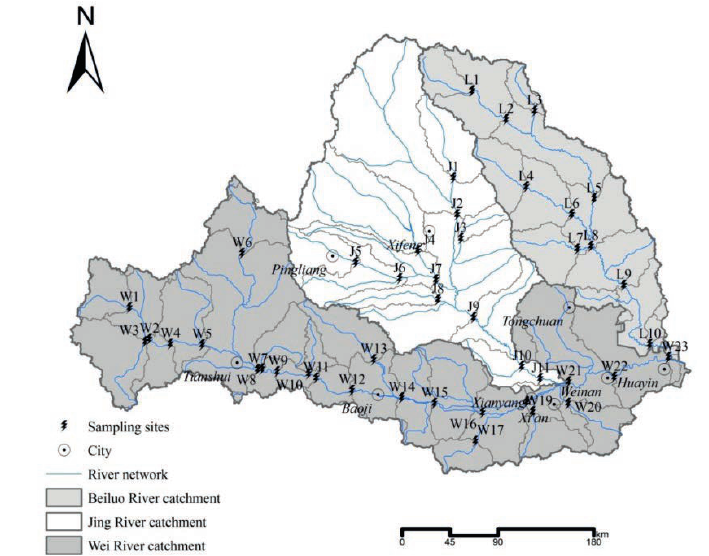
Fig. 1 Study area and location of sampling